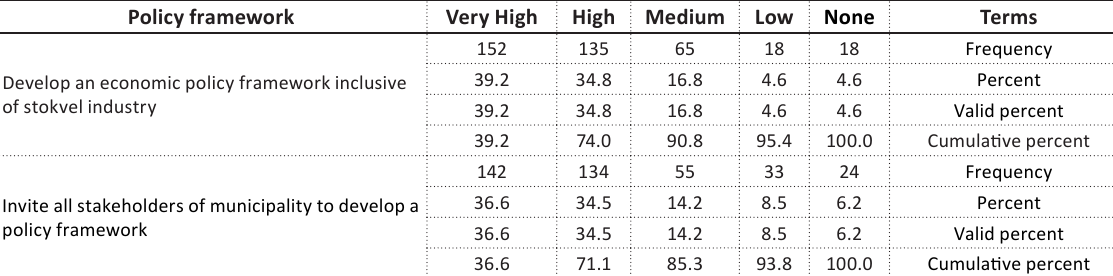
Table 3. Responses on municipality developing a policy framework